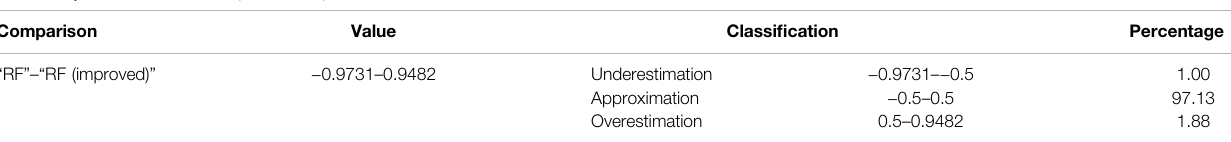
TABLE 9 | Classi fi cation of comparison